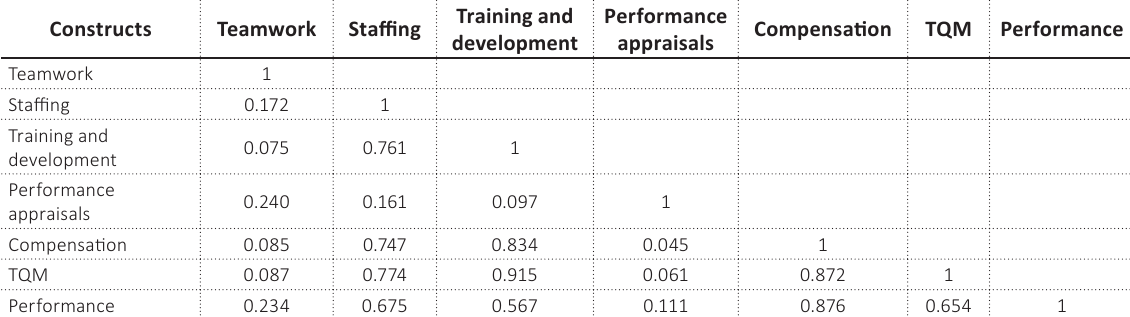
Table 2. Correlation